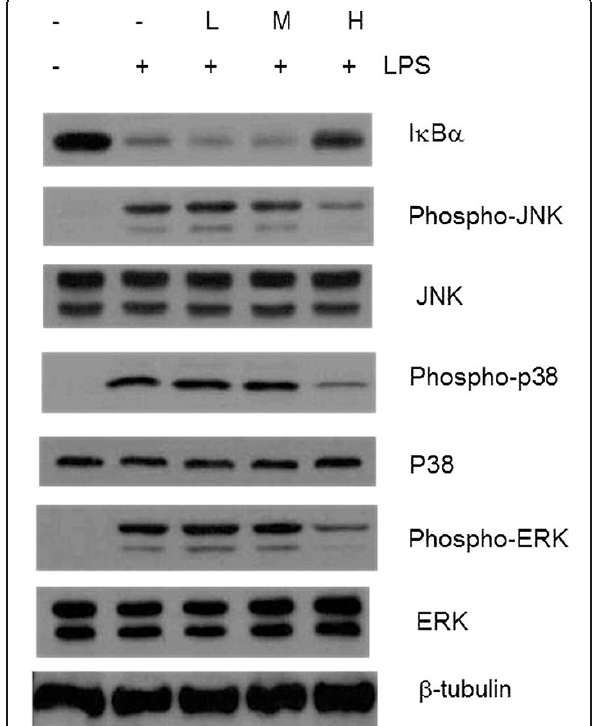
Figure 5 Effect of size - based CWE fractions on signaling molecules. Peritoneal macrophages were 1 h pretreated with 120 μ g/ml of low molecular weight(MW) fraction(L), 30 μ g/ml of middle MW fraction (M), and 50 μ g/ml of high MW fraction (H) according to the yield ratio relative to total CWE. After LPS stimulation for 15 min, signaling molecules in whole protein extracts were examined by Western blot analysis. One of the five experiments is